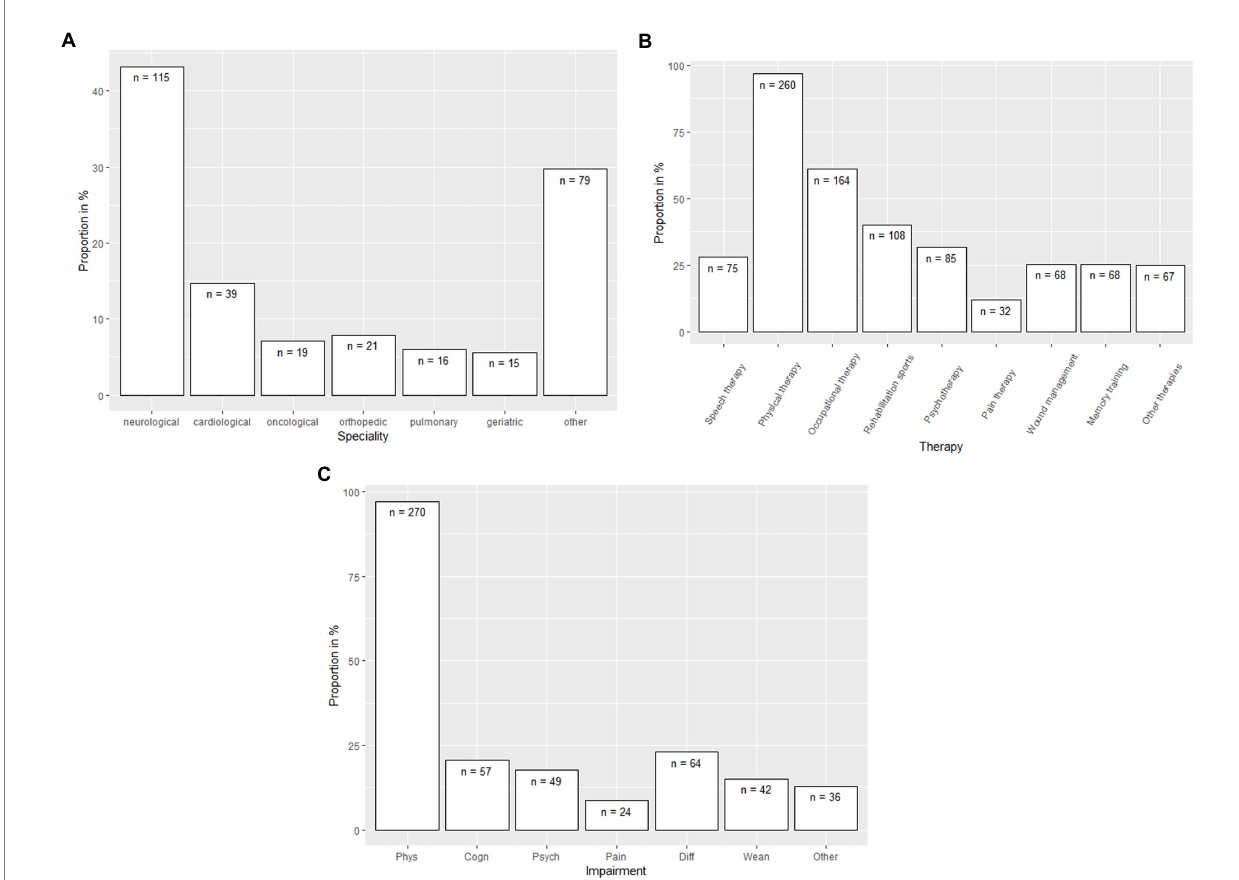
FIGURE 2 (A) Specialties of inpatient rehabilitation utilized by sepsis survivors (combined for 6 and 12 months interview). (B) Therapies received in rehabilitation by sepsis survivors (combined for 6 and 12 months interview). (C) Impairments of sepsis survivors addressed during the rehabilitation (combined for 6 and 12 months